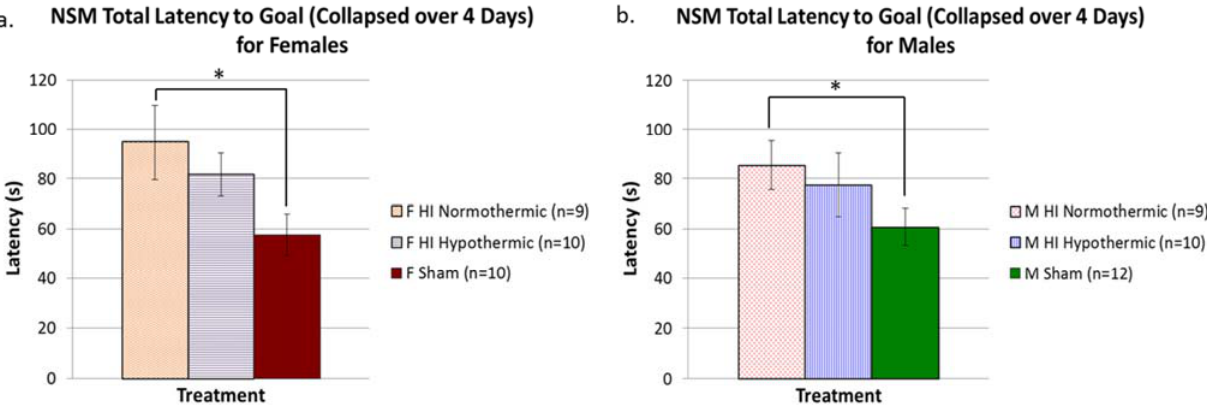
Figure 4. ( a ) A one-way ANOVA to assess Treatment effects did not reveal any